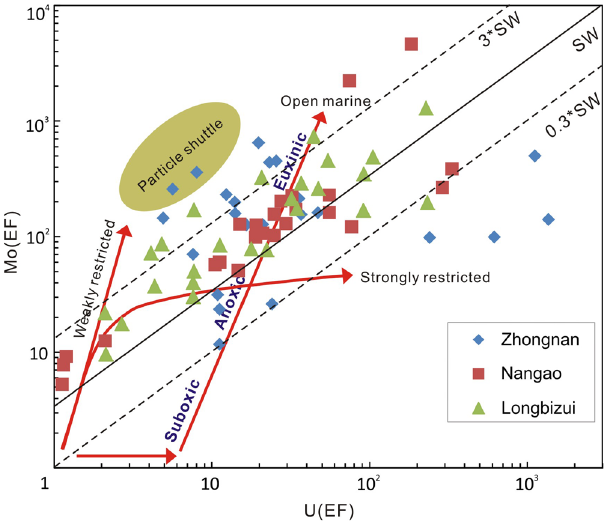
Figure 4. Plots to show Mo (EF) versus U (EF) for investigated sections. The solid diagonal line shows the seawater Mo/U molar ratio (1 × SW) and the dashed lines multiples thereof (3 × SW, 0.3 × SW). The olive-green field represents the “particulate shuttle” trend, characteristic of depositional systems in which intense redox cycling of metal, especially Mn oxyhydroxides occurs 33